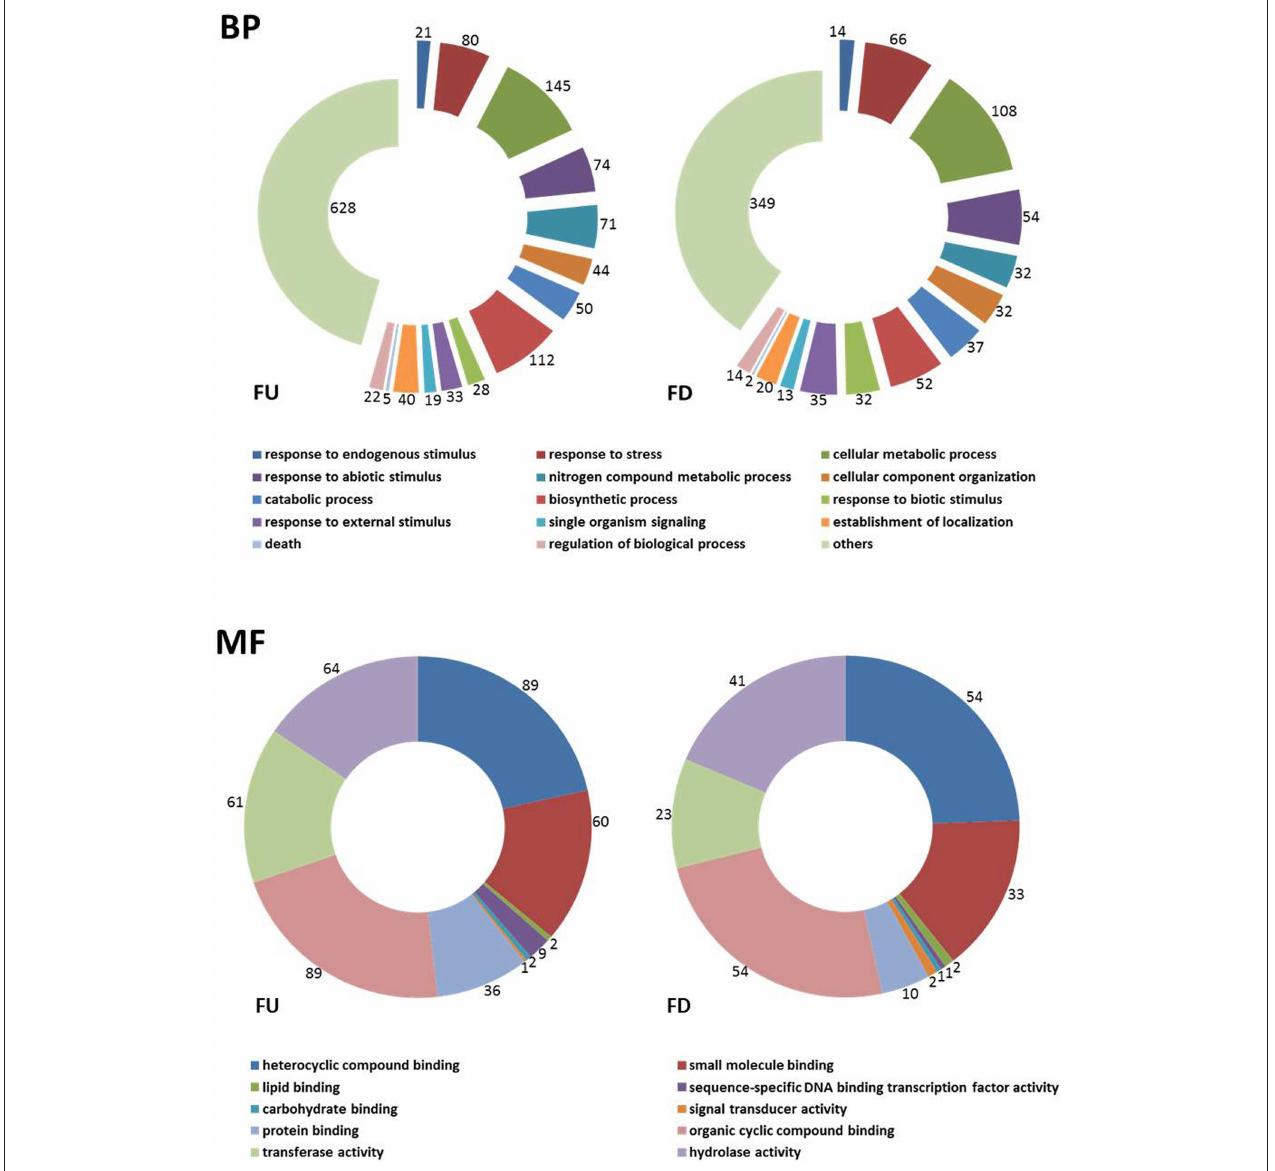
FIGURE 1 | “Level 3” Gene Ontology (GO) “Biological processes” (BP) and “Molecular function” (MF) terms distribution of 381 unigenes repressed (FD) and 585 induced (FU) in olive ( Olea europaea L.) aerial tissues colonized by Verticillium dahliae . Unigenes were categorized using the “Blast2GO” software.